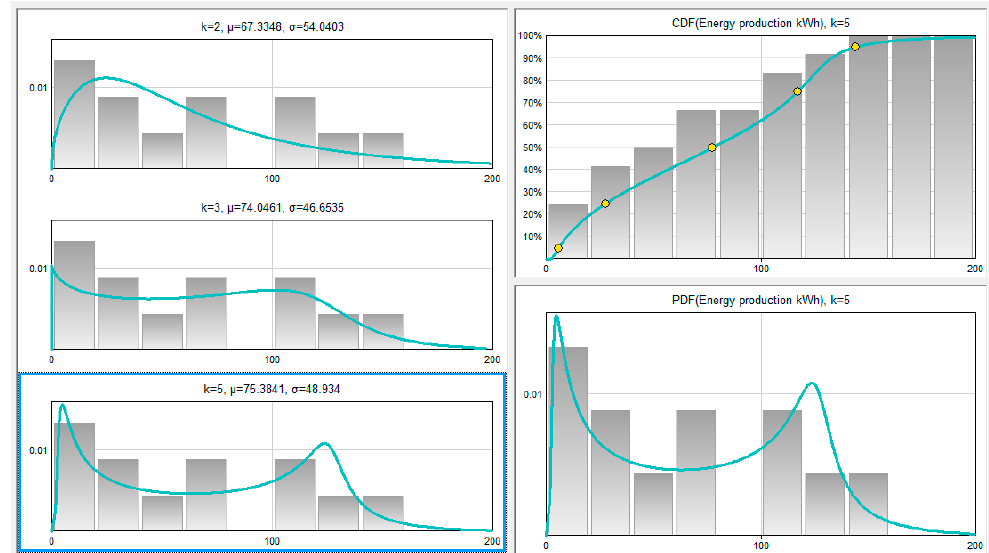
Figure 10. Empirical Distribution Function (sea color line) along with quantile parameters (yellow symbols) and Probability Density Function (sea color line) for the monthly energy produced by the WSEI carport in the year 2022 for various k coefficients.